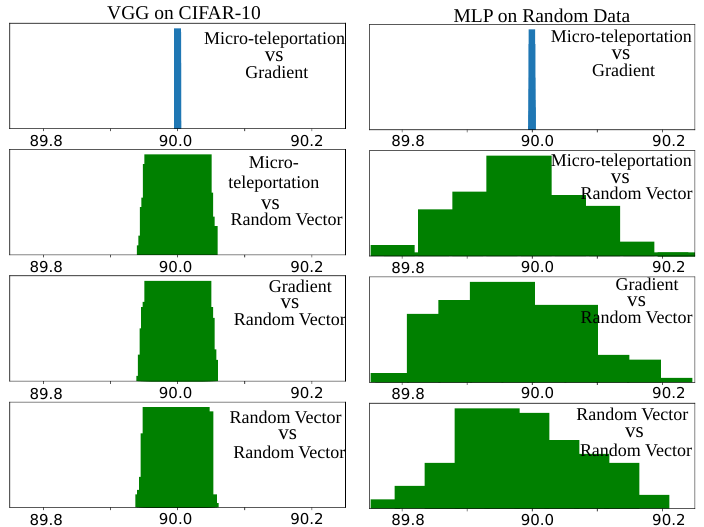
Figure 3. (Top) Angle histograms between micro-teleportation vectors and back-prop. gradients for VGGnet on CIFAR-10 data and MLP on random data. The other rows are angle histograms between micro-teleportation vectors and random vectors, between gradient and random vectors and between random